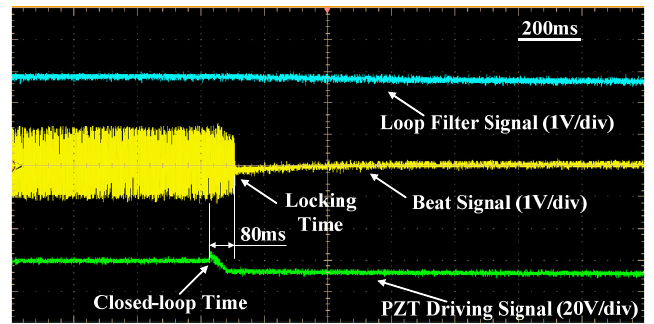
Figure 4. Frequency acquisition and phase locking process at an 8 MHz initial frequency difference.